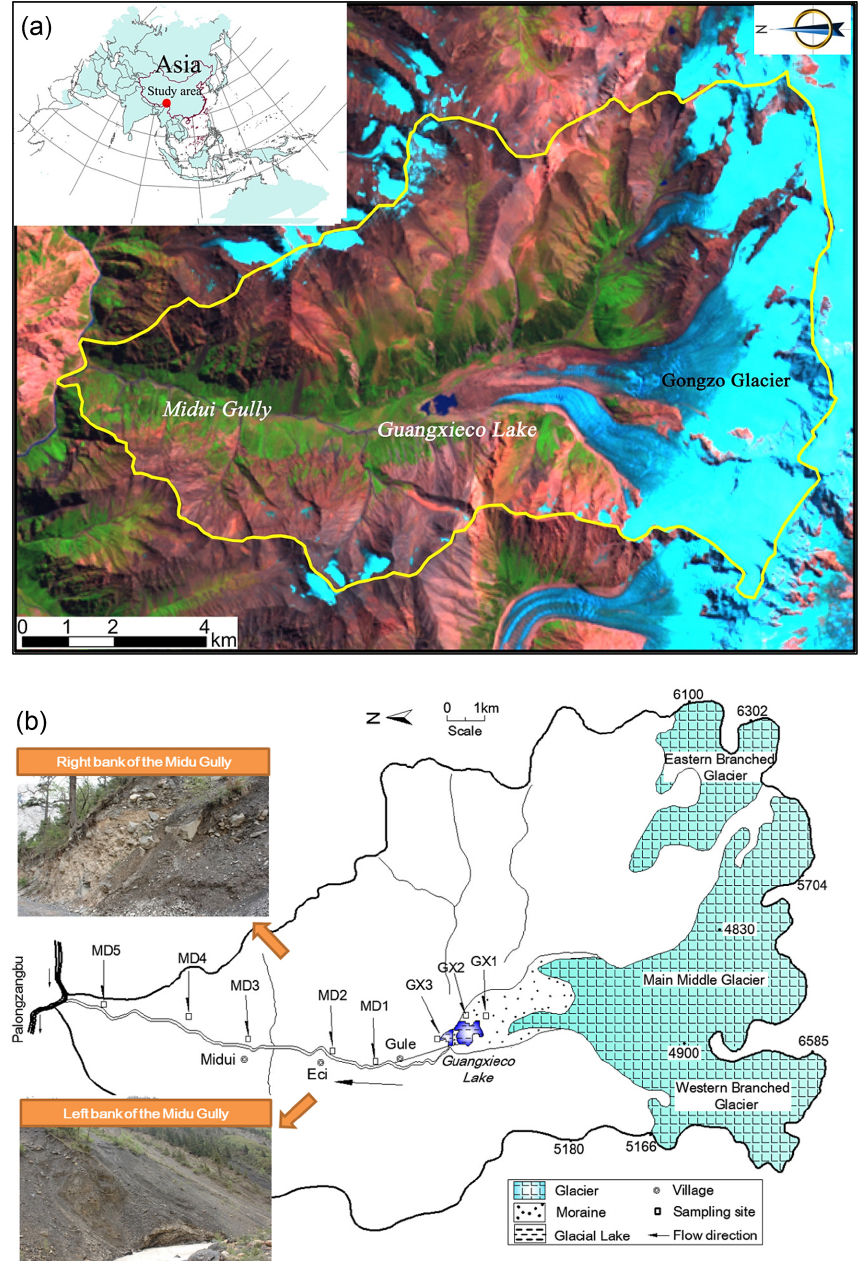
Figure 1. Landscape and background of the study area. (a) TM image of 8 September 2005. (b) Configuration of the Midui Gully drainage basin (landform is modified from Cui et al., 2010, Fig. 4). Poorly sorted, boulder sediments exposed on both sides of the Midui Gully. The Guangxieco lake soil sampling sites (GX1–3) and the Midui Gully soil sampling sites (MD1–5) are mentioned in Sects. 3.2 and 4.2,